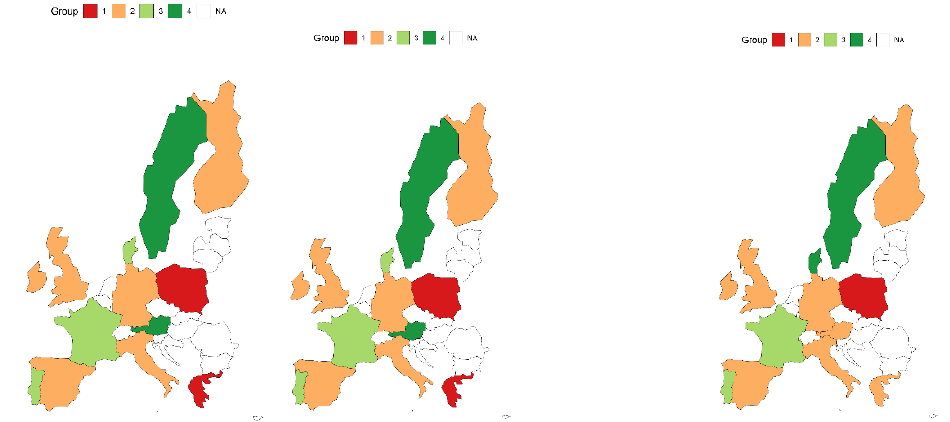
Figure 9. SISED for individual EU countries in 2019–2021.